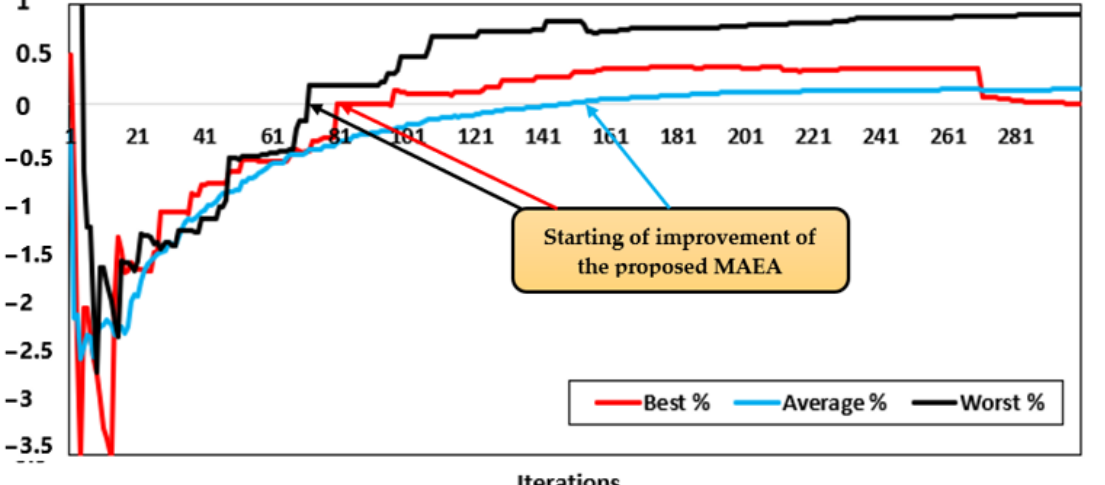
Figure 5. Convergence rates of the proposed MAEA and the basic AEA of Case 1.